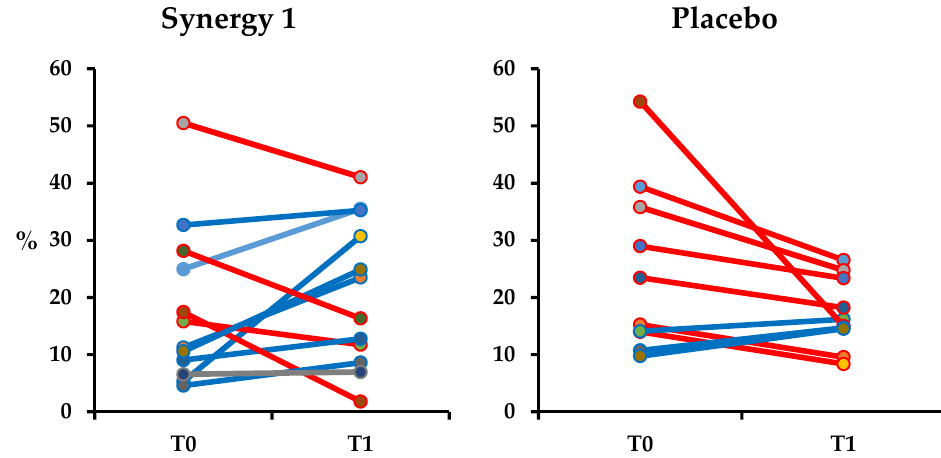
Figure 2. Urinary excretion of mannitol (M) in individuals from Synergy 1 and placebo group, before (T0) and after the intervention (T1), expressed as a percent (%) of total ingested M.